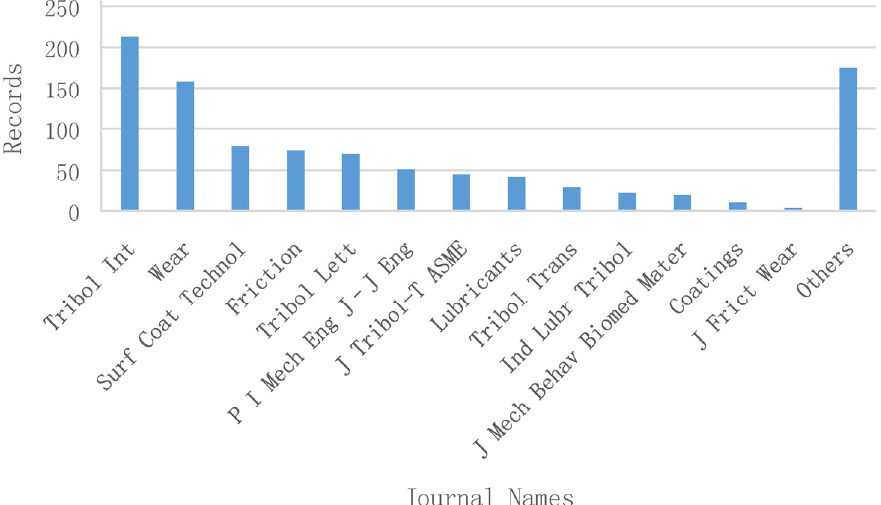
Fig. 1 Number of references in the main journals in tribology and the related to theoretical simulation and biological applications of tribological